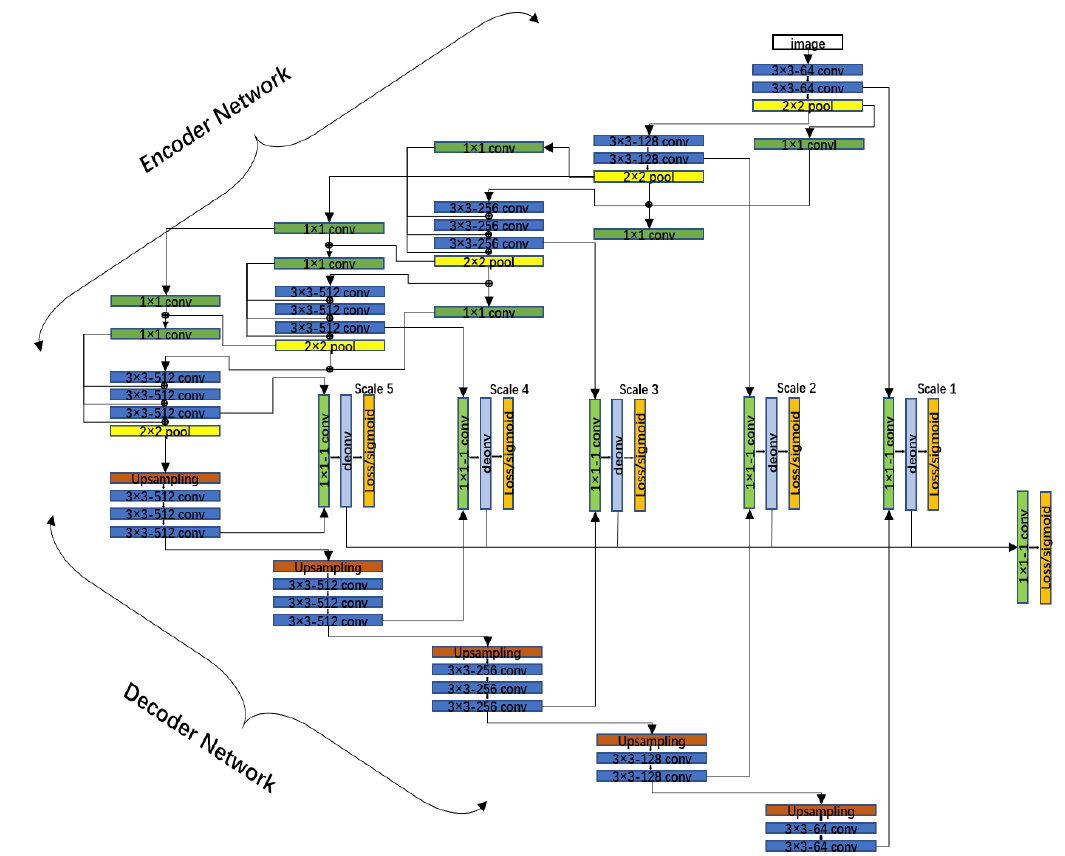
Figure 4. Architecture of the DenxiDeepCrack